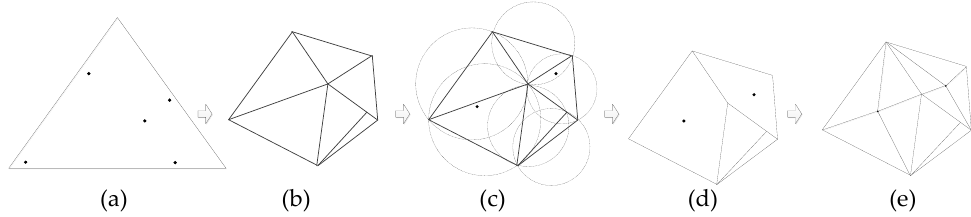
Figure 7. Bowyer – Waston algorithm: ( a ) generate a super triangle with discrete points; ( b ) generate an initial grid; ( c ) add new points; ( d ) generate two cavities; ( e ) connect new points and the vertices of cavities.